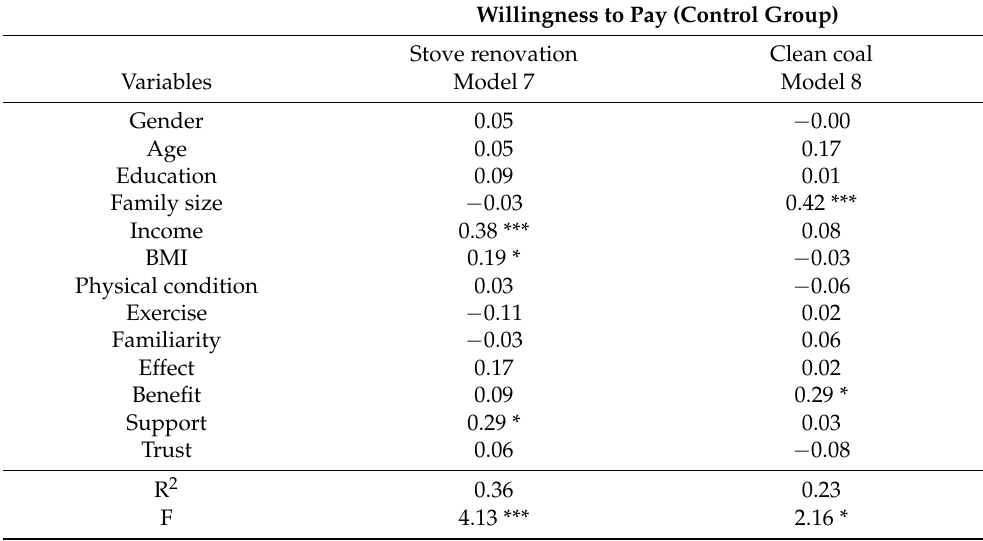
Table 6. Multiple linear regression models of protective behaviors by demographic variables and risk perception